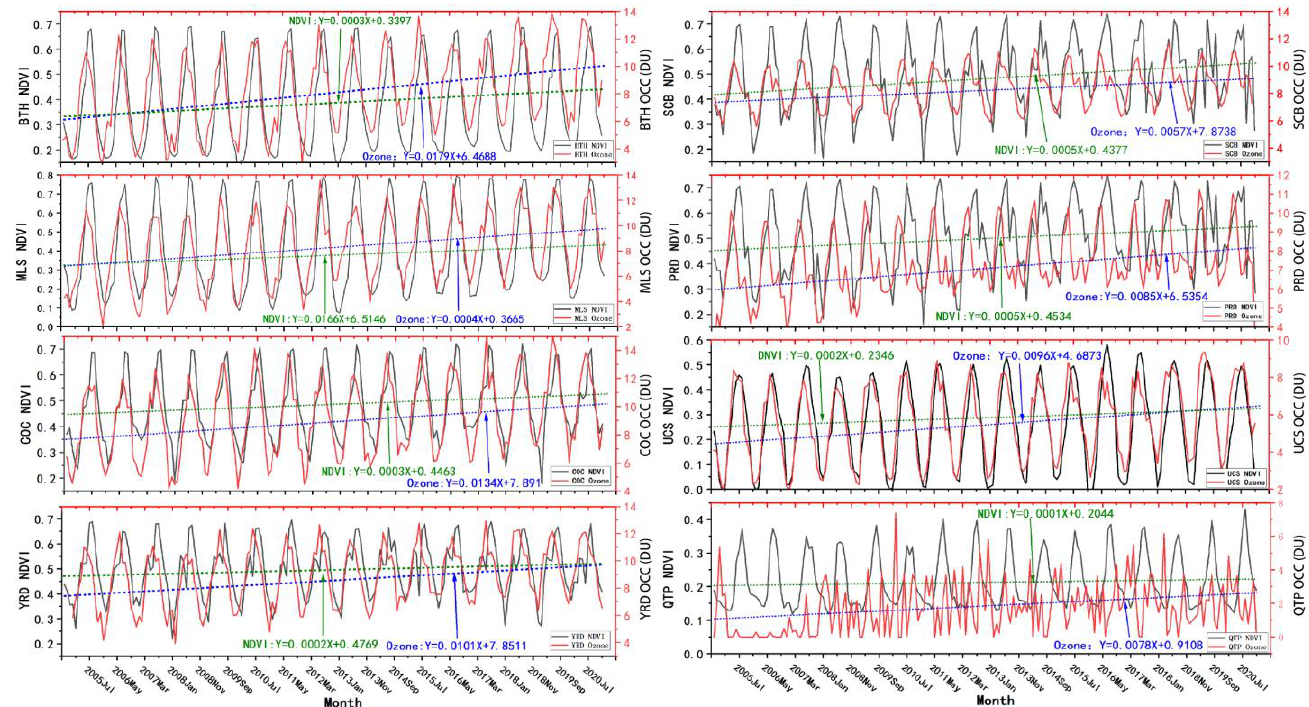
Figure 11. Interannual variation in NDVI and OCC LT in mainland China.